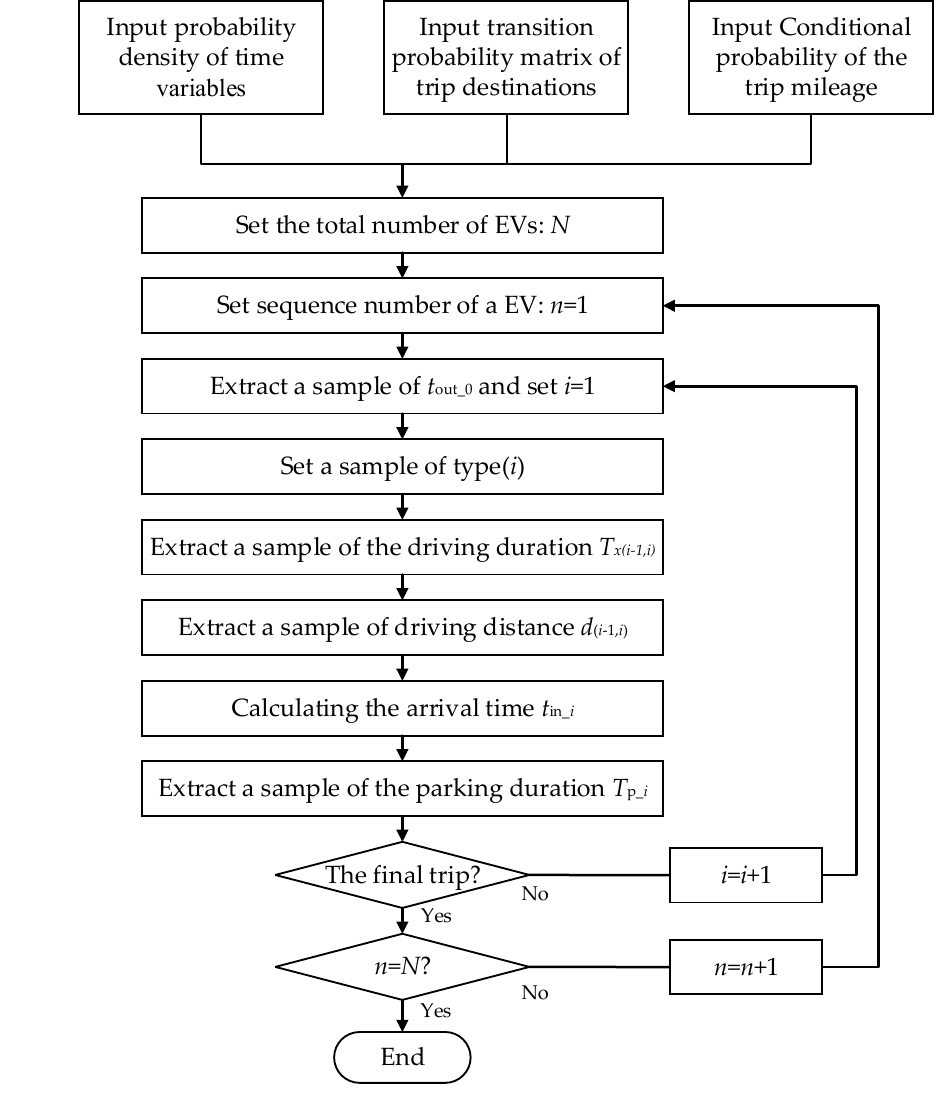
Figure A2. Flowchart of trip chain simulation. Table A1. Simulation results of daily charging demand.